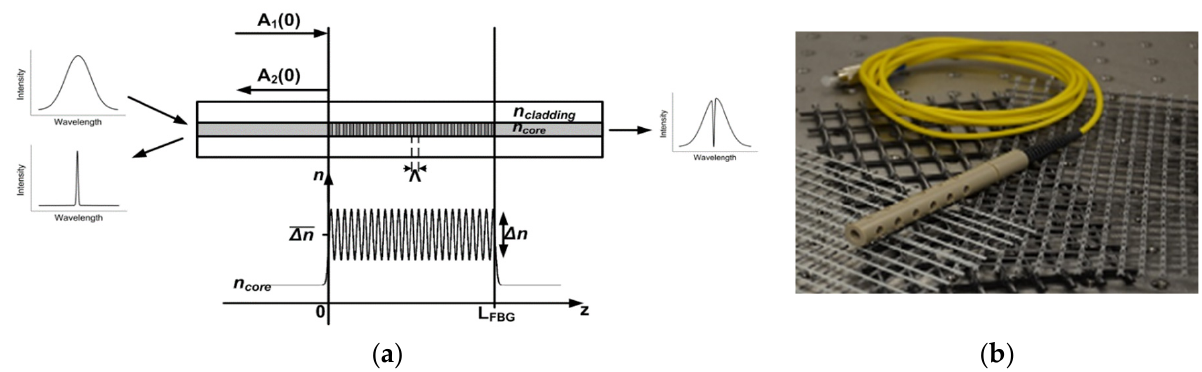
Figure 9. ( a ) Principle of operation of FBGs: periodic modulation of the refractive index of the fiber core which causes that only the Bragg wavelength is reflected and all other wavelengths to propagate through to the end of the optical fiber. ( b ) Example of a packaged FBG sensor that has been applied for the measurement of relative humidity. Reprinted with permission from ref. [68]. Copyright 2016 Procedia Technology.